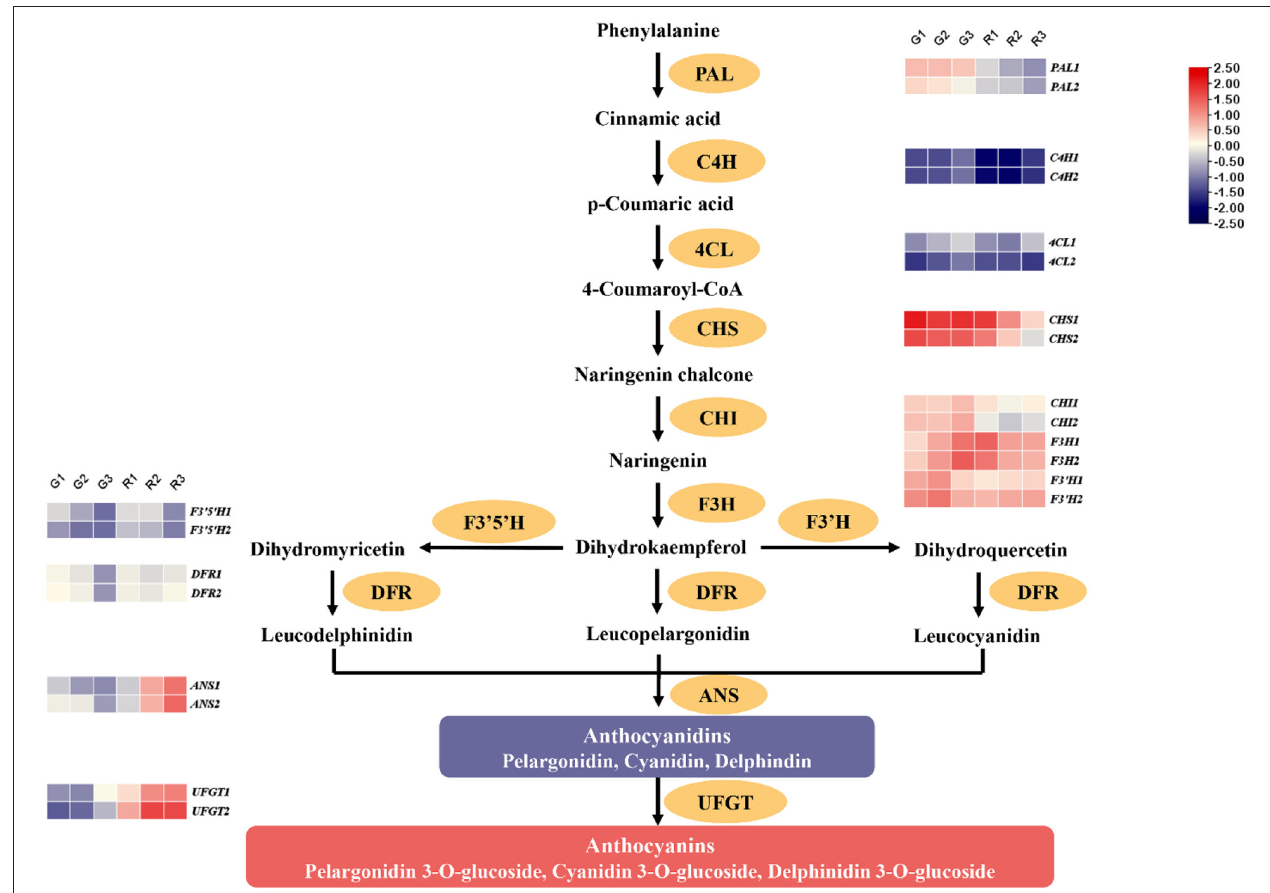
FIGURE 5 | Expression patterns of genes encoding enzymes of the anthocyanin synthesis